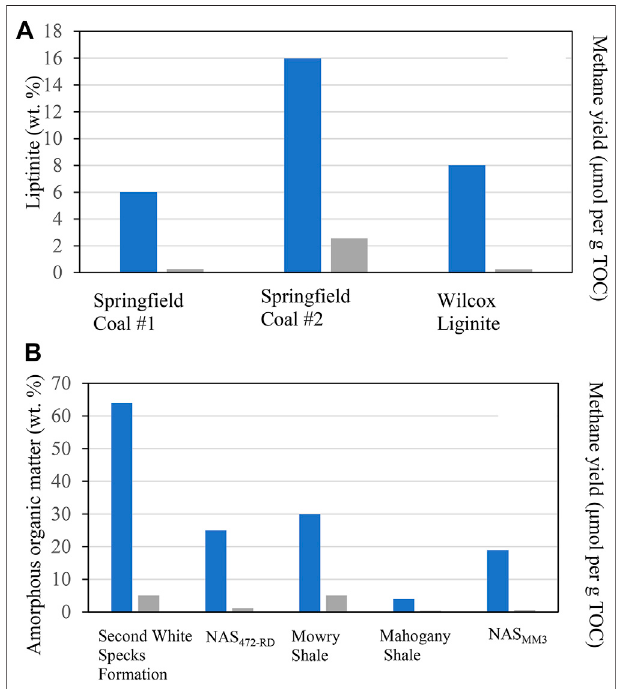
FIGURE 8 | Liptinite (wt. %, in blue) and catalytic methane generation yield ( μ mol per g TOC, in gray) (A) Amorphous organic matter (wt. %, in blue) and catalytic methane generation yield ( μ mol per g TOC, in gray) (B) of long- termheatedsourcerockchips.Theorganicpetrographiccompositionin % is on a mineral matter free basis. The presented yield data are averages of two or more independent